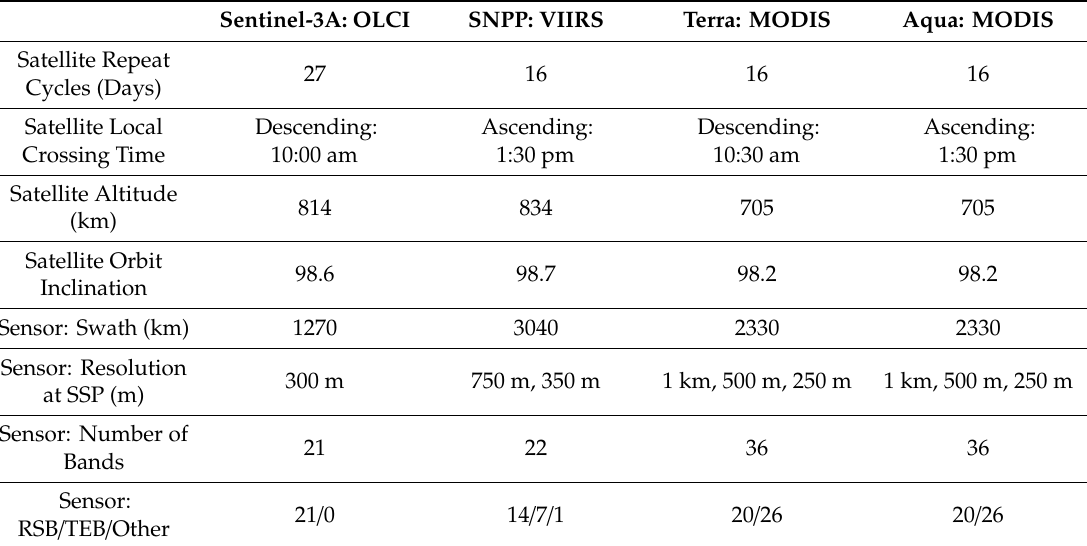
Table 1. Selected information and parameters for the four satellites and the multispectral instruments.